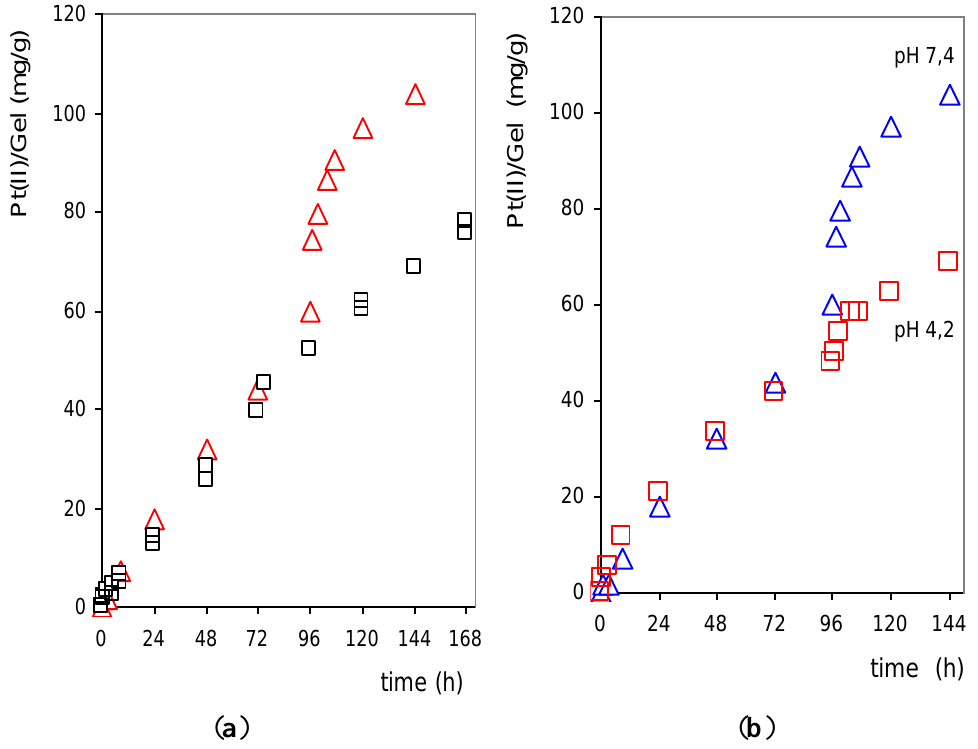
Figure 11. ( a , left). Comparison of the release pattern of Pt(II) from the hydrogel AVa-2 loaded with cisPt: releasing profile at 25 °C (squares), and effect of increasing temperature to 36 °C (red triangles), in PBS buffer pH 7.40; ( b , right). Comparison of the release pattern of Pt(II) from the hydrogel AVa-2 loaded with cisPt: releasing profile at pH 7.4 (blue triangles, PBS buffer), and pH 4.2 (red squares, acetate buffer) at 25 °C. Pulse of temperature to 36 °C after 96